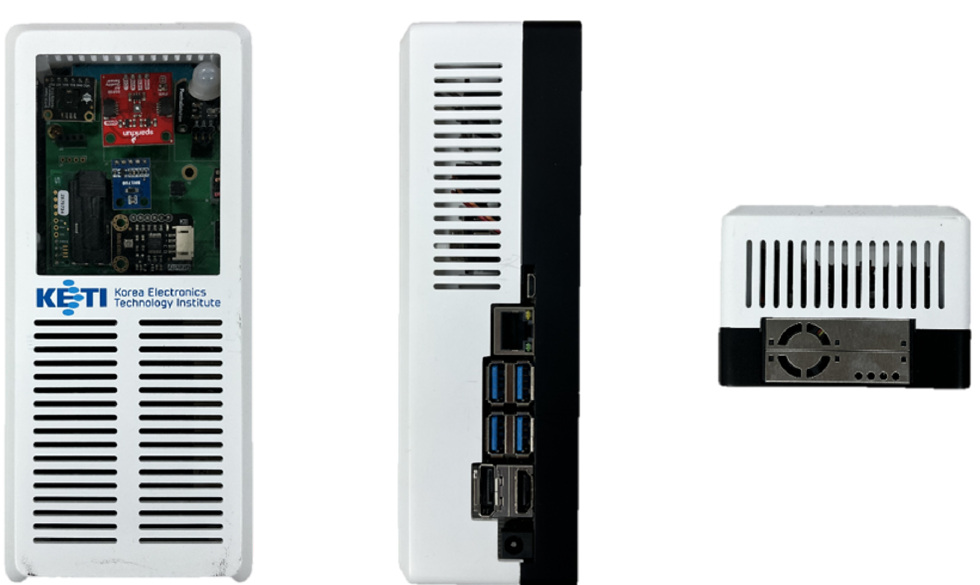
Figure 1. Intelligent multi-environment sensor module: ( left ) front of the module ( center ), side of the module, and ( right ) top of the module.